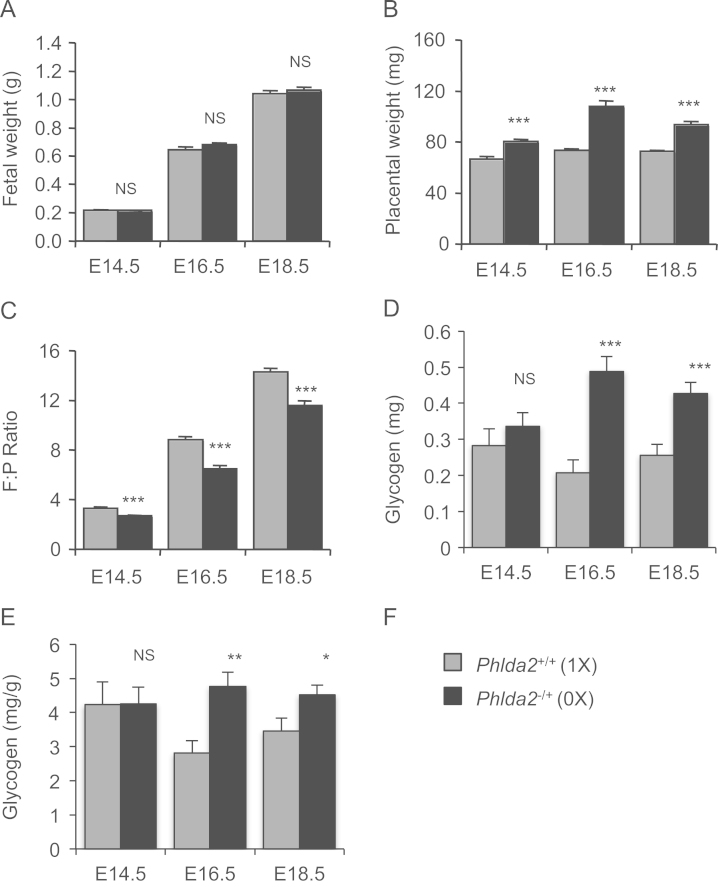
Influence of Phlda2 deficiency on foetal and placental weights, and glycogen accumulation. A. Weights of non-transgenic and Phlda2−/+(0X) fetuses at the indicated gestational stages. Phlda2−/+(0X) fetuses weigh the same as their non-transgenic counterparts at each time point. B. Weights of placentae at the indicated gestational stages. Phlda2−/+(0X) placenta weigh more than their non-transgenic counterparts at each timepoint. C. Comparison of F:P ratios on the 129 background. D. Direct biochemical determination of total glycogen (mg) stored in Phlda2+/+ and Phlda2−/+(0X) placenta at E14.5, E16.5 and E18.5. Phlda2−/+(0X) placenta contain significantly more glycogen than non-transgenic placenta at E16.5 and E18.5. E. Milligrams (mg) of glycogen stored per gram of placenta in Phlda2+/+ and Phlda2−/+(0X) placenta at E16.5 and E18.5. Numbers of samples given in Supplemental Table S7. Error bars represent SEM. Statistical significance calculated using t-test: NSP>0.05, *P<0.05, **P<0.01, and ***P<0.005.